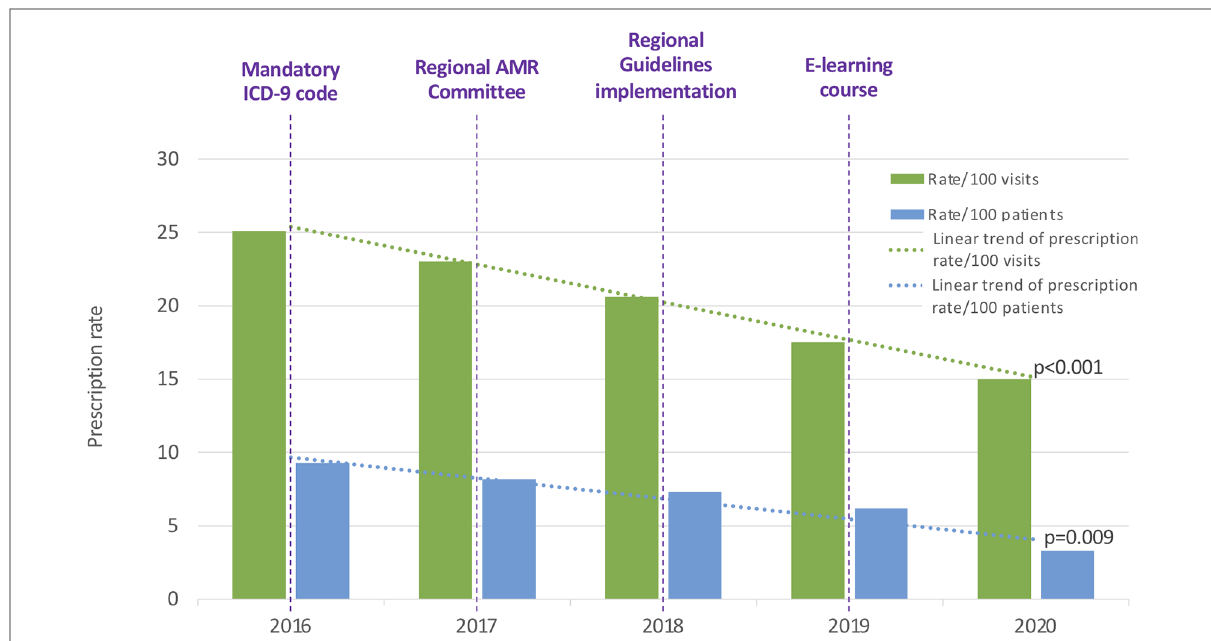
FIGURE 1 Annual antibiotic prescription rates per 100 patients and 100 visits. ICD-9: International Classi fi cation of Diseases-9. AMR, Antimicrobial Resistance.